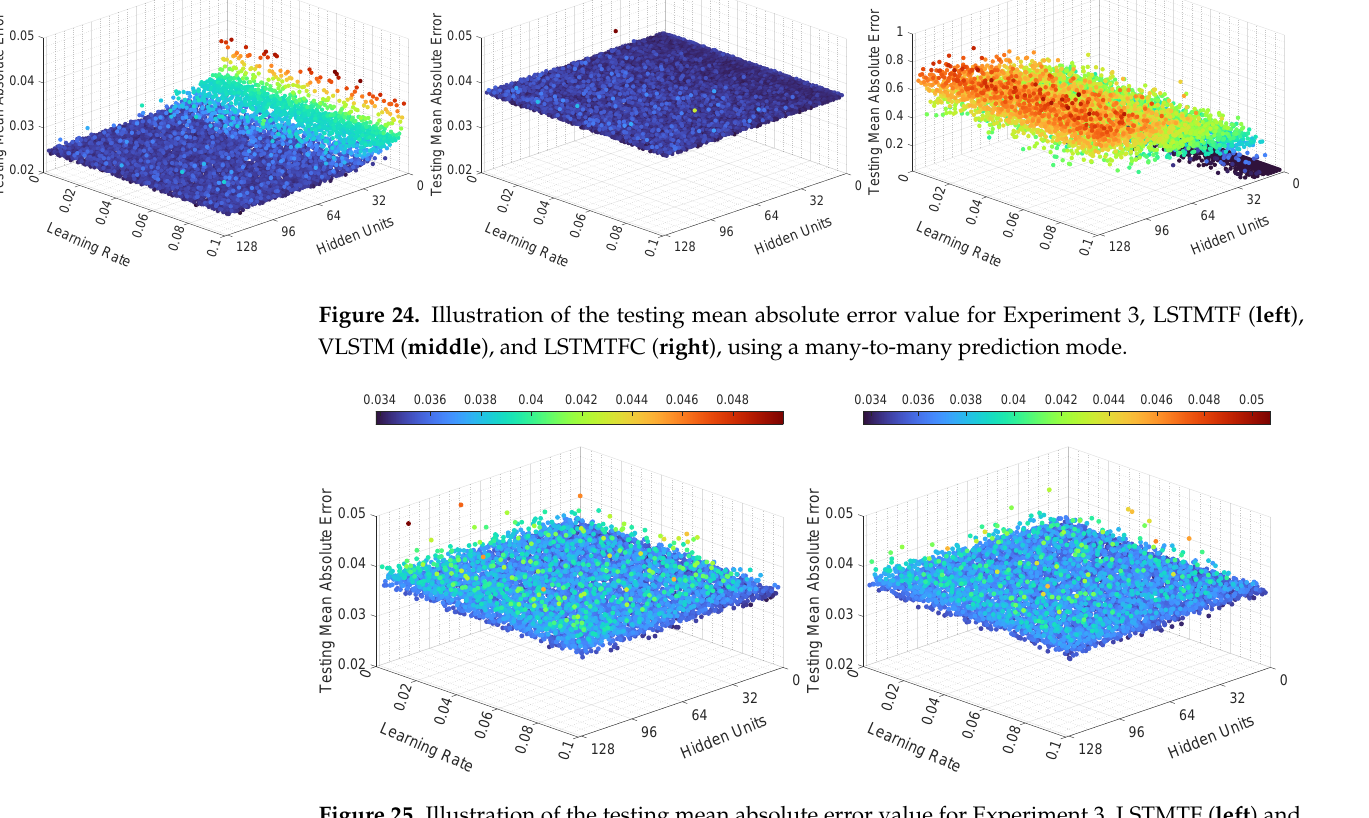
Figure 25. Illustration of the testing mean absolute error value for Experiment 3, LSTMTF ( left ) and VLSTM ( right ), using a many-to-one prediction mode.